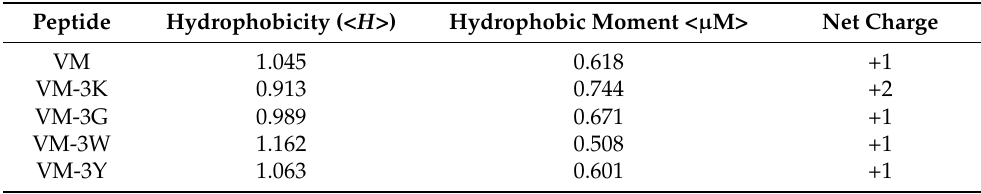
Table 2. The sequences of the peptide VM and its analogues. Hydrophobicity ( H ) was calculated using HeliQuest [21].